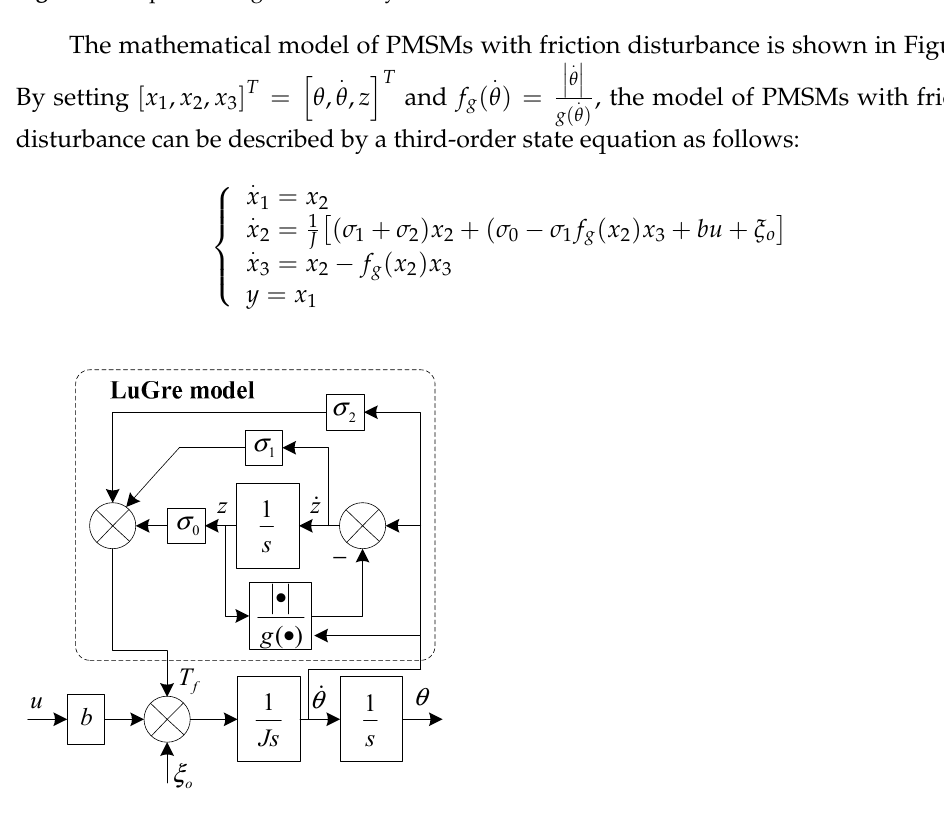
Figure 2. Simplified diagram of the dynamic characteristics of PMSMs.